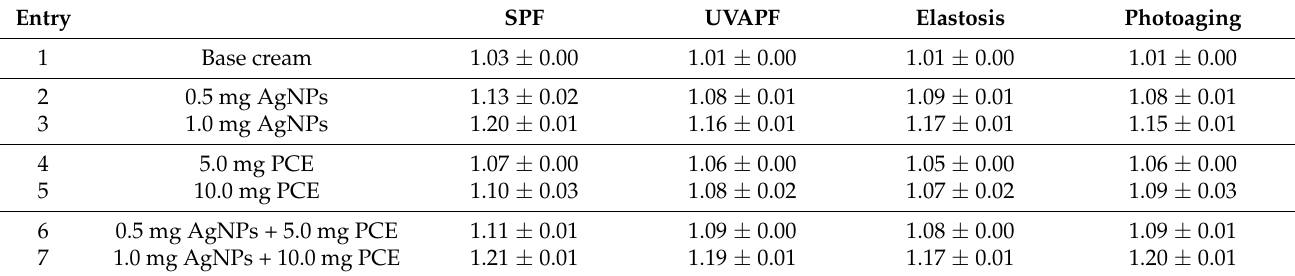
Table 4. Sun protection factor (SPF), UV-A protection factor (UVAPF) and different biological effective protection factors (BEPFs) against other biological effects of the UV-A radiation (elastosis and photoaging). Values are expressed as mean ± standard